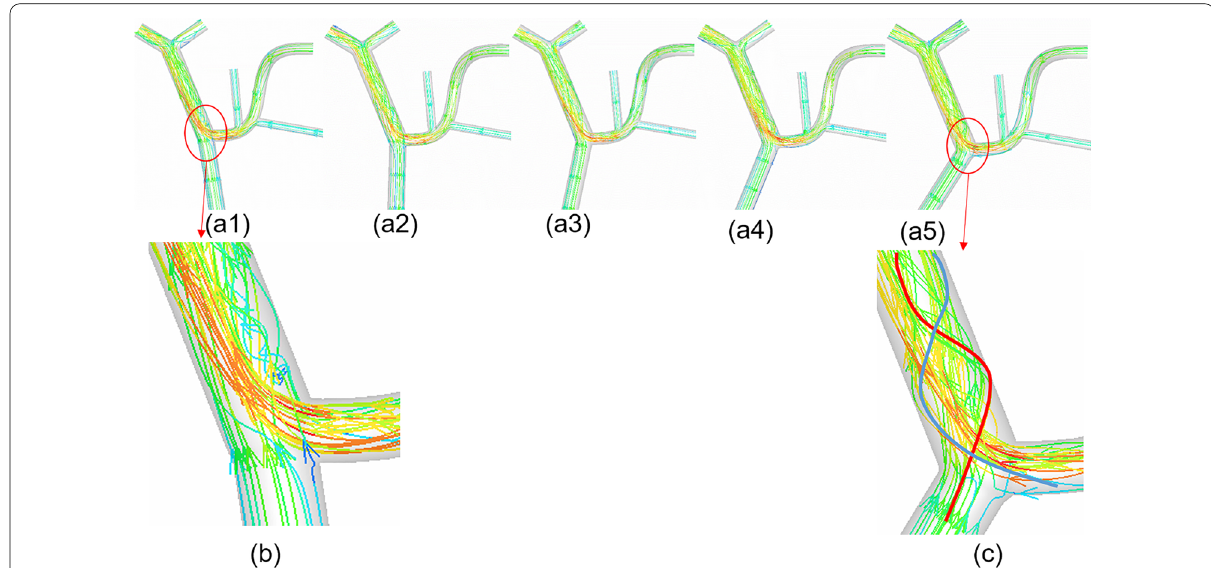
Fig. 4 The flow patterns in the models; a 1 , a 2 , a 3 , a 4 , a 5 represent the model with α detail at the local proximal portal vein in the ideal model with α